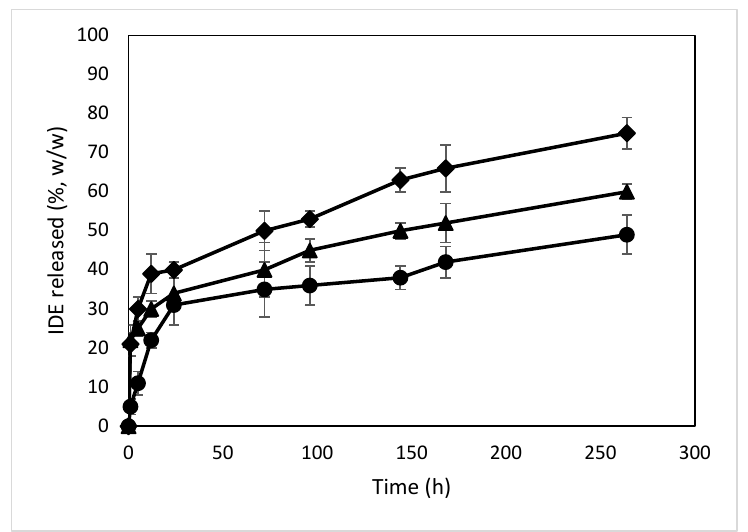
Figure 13. In vitro release profiles of IDE from IDE/ACyD8-NPs in PBS (pH 7.4). Sample A (circle), sample B (triangle), sample C (diamond).